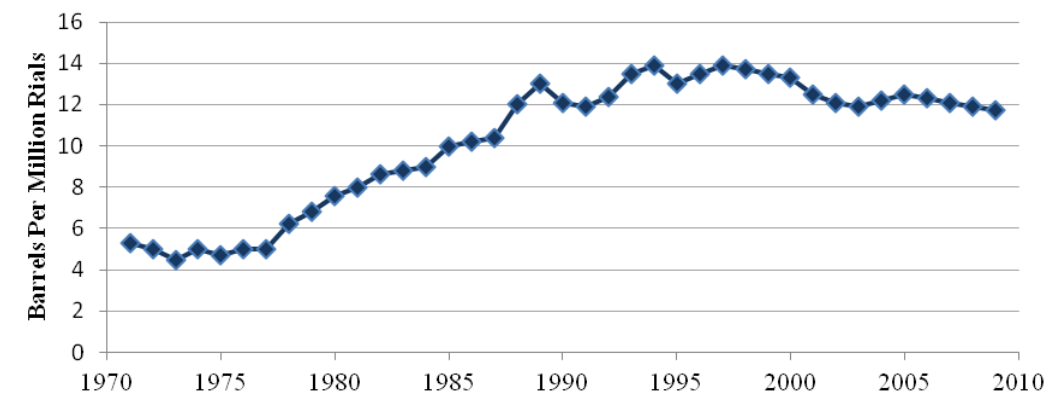
Figure 3. Energy intensity in